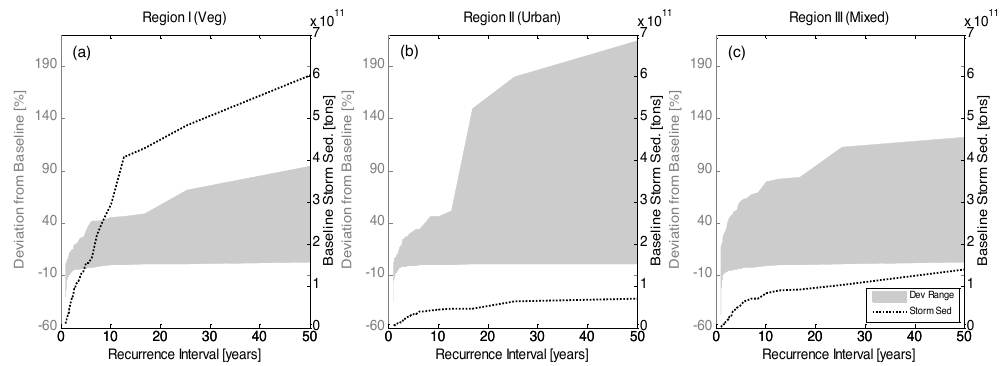
Table 6. Historical comparison of mean annual sediment flux [tonyr − 1 ] for observed and archetypal watersheds for the 1969– 1995 data period. Mean annual sediment flux values were obtained from Inman and Jenkins (1999).